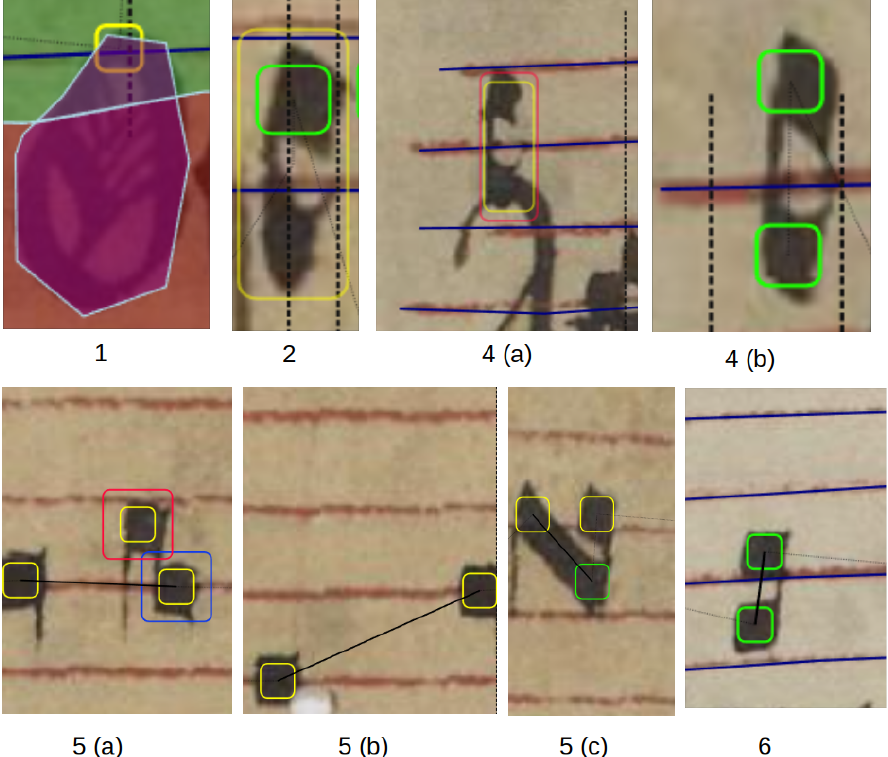
Figure 4. Common errors of the symbol detection, which are corrected by the post-processing pipeline. The yellow and green boxes indicate whether the symbol is on the staff line or between a staff line. Notes, which also have a red border, are the symbols that are “uncertain” and are used for correcting missing symbols in the baseline symbols. The green, red and purple overlay indicates the region. Areas in the first image with green overlay are music-, red are lyric- and purple are drop capital regions. The numbers (1, 2, 4a, 4b, 5a, 5b, 5c, 6) under each image refer to the